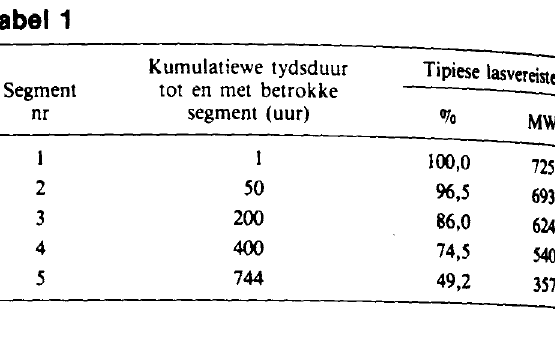
Kumulatiewe tydsduur Tipiese lasvereista